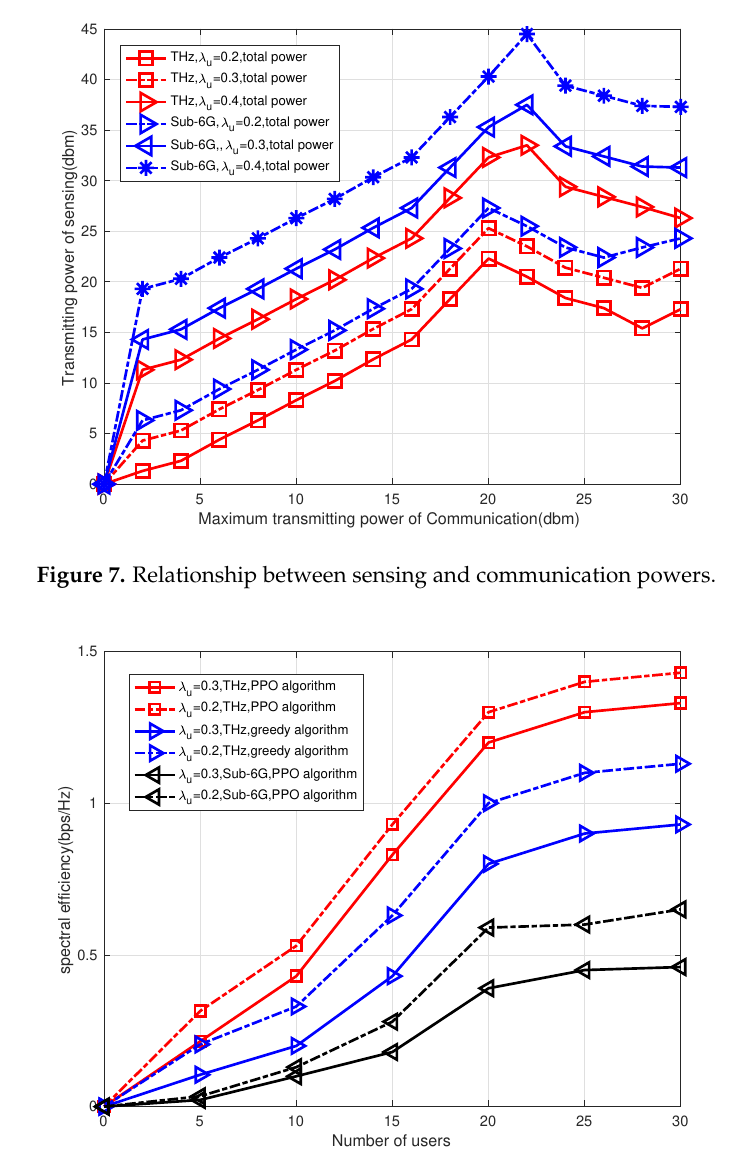
Figure 8. Relationship between frequency efficiency and number of